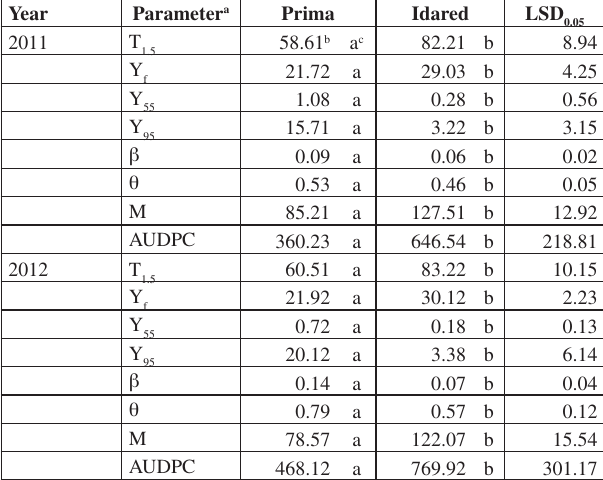
Table 2 Parameter estimates for the descriptive disease variates of the brown rot incidence curves for three apple cultivars (2011-2012, Mándok, Hungary)